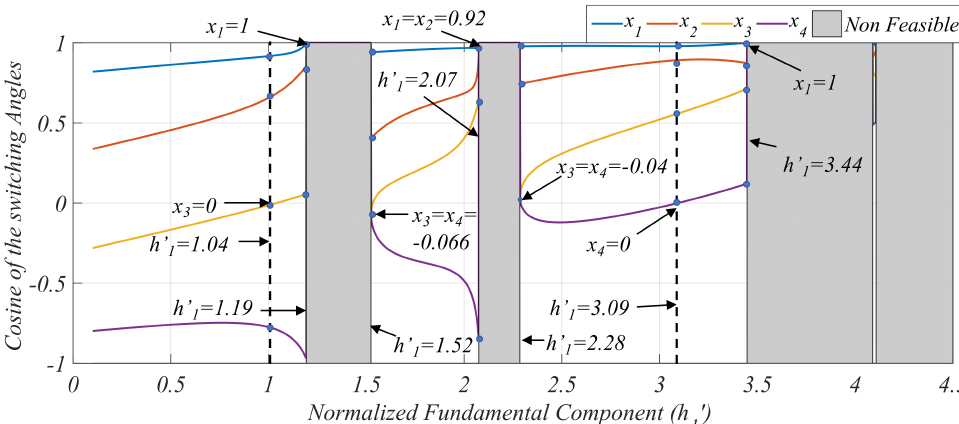
Figure 4. Behavior of the cosine of the switching-angles ( X ) according to the fundamental component, h (cid:48) , when the third, fifth and seventh order harmonics are equal to 1